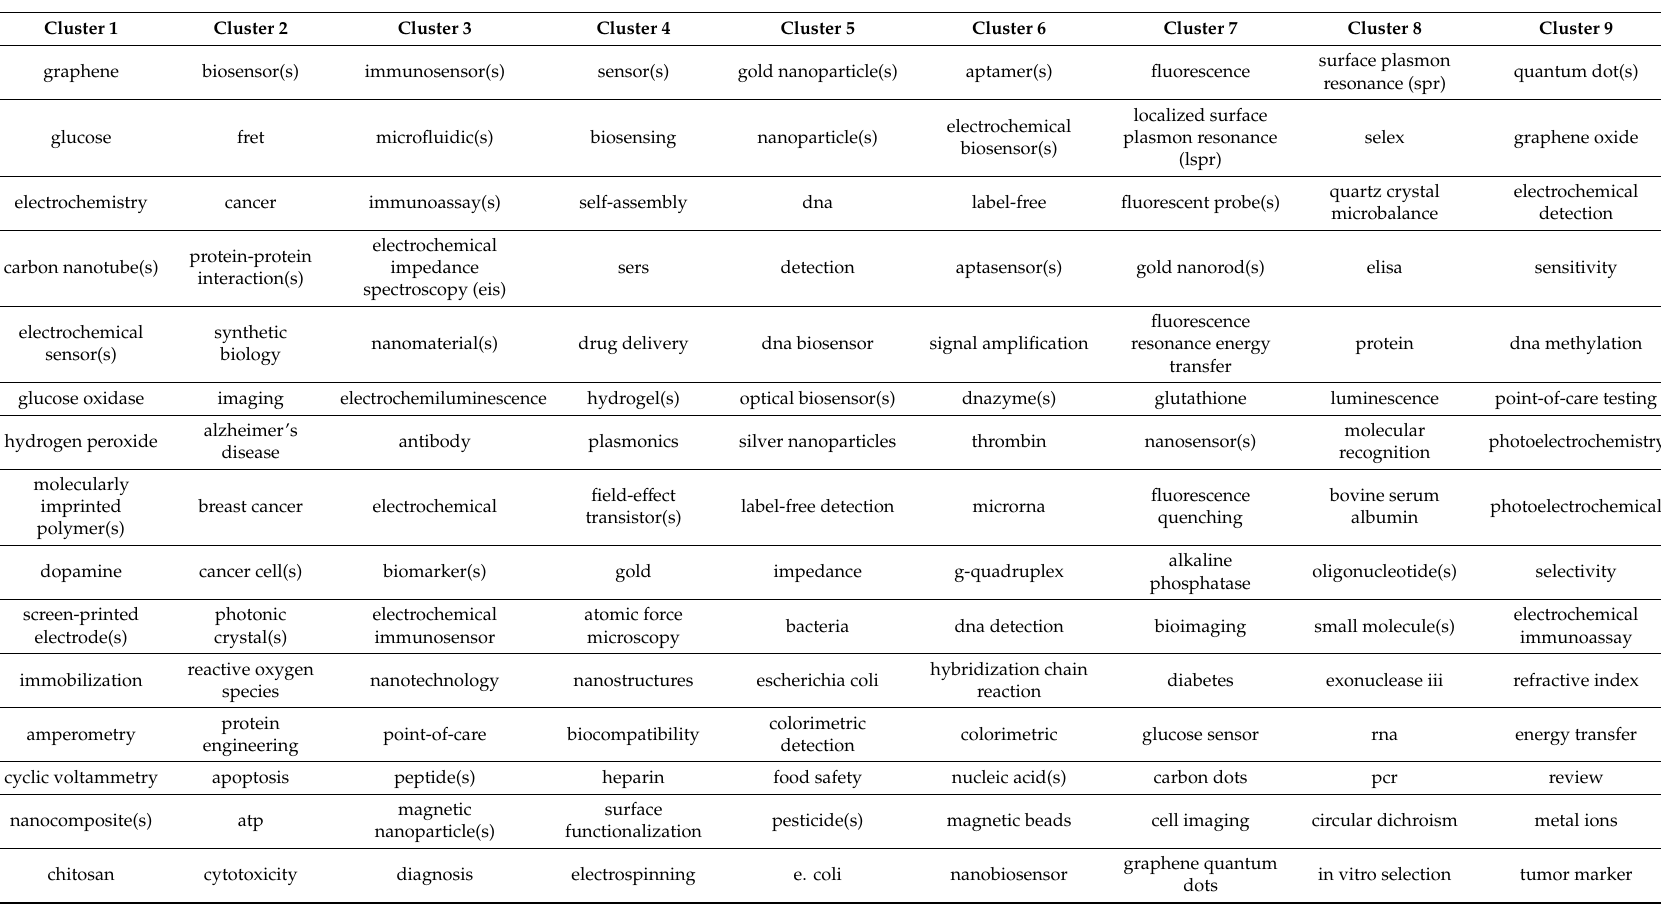
Table 8. The top 20 most frequent Other Terms in each of the clusters depicted in Figure 22. Grey shades are added to rows to improve